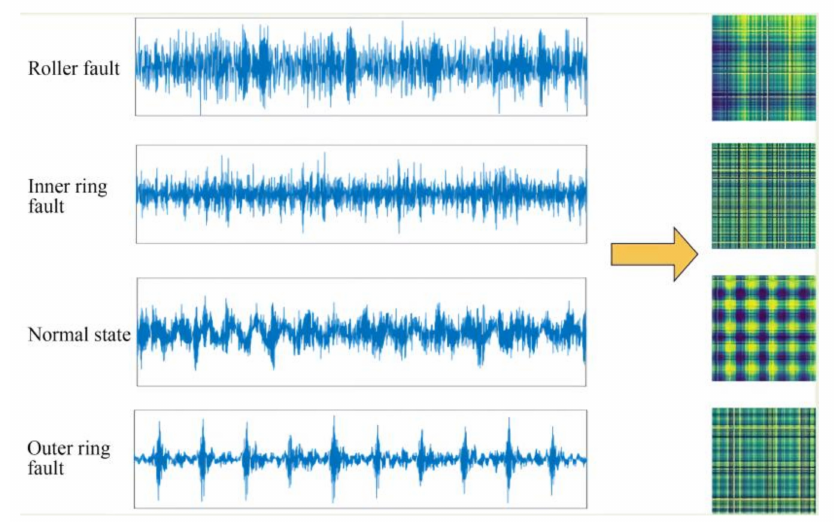
Figure 7. Time-domain waveforms and GAF diagrams.